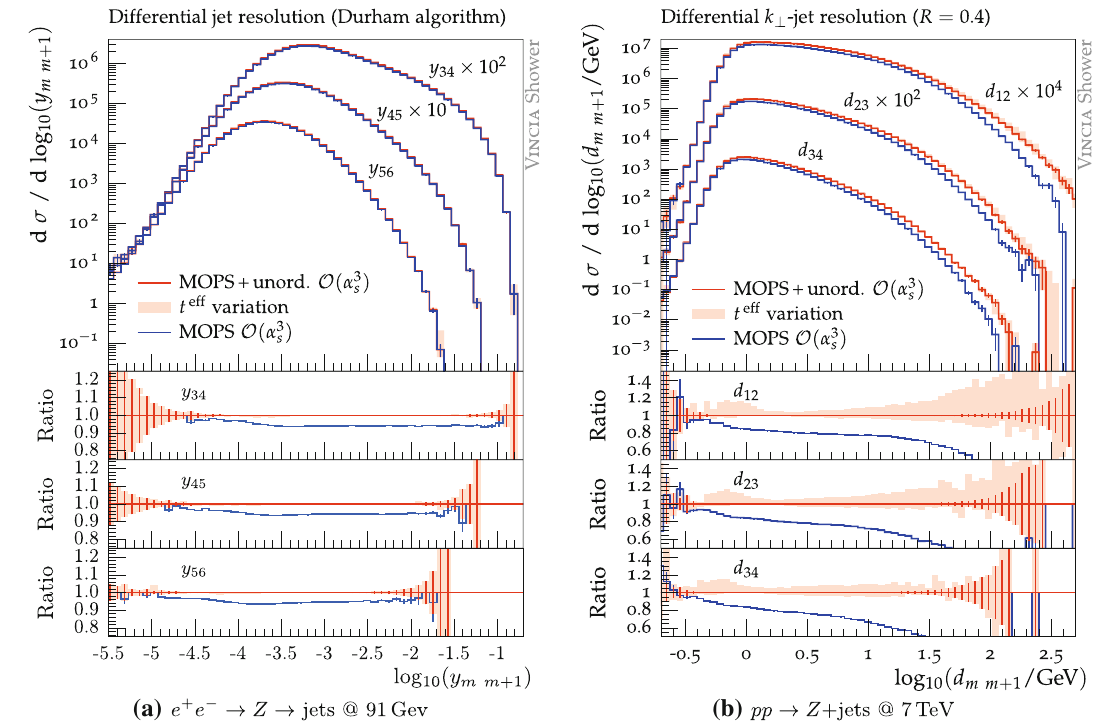
Fig. 2 Pythia 8.2.26+ Vincia 2.2 predictions for jet resolution measures d mm + 1 and y mm + 1 (the longitudinally invariant k ⊥ jet algorithm with R = 0 . 4 for hadronic initial states and the Durham jet algorithm for lepton collisions). ME corrections are applied for ≤ 3 emissions. The red band is obtained by varying the effective scale t eff [ GeV ] in non-shower events by factors of 2